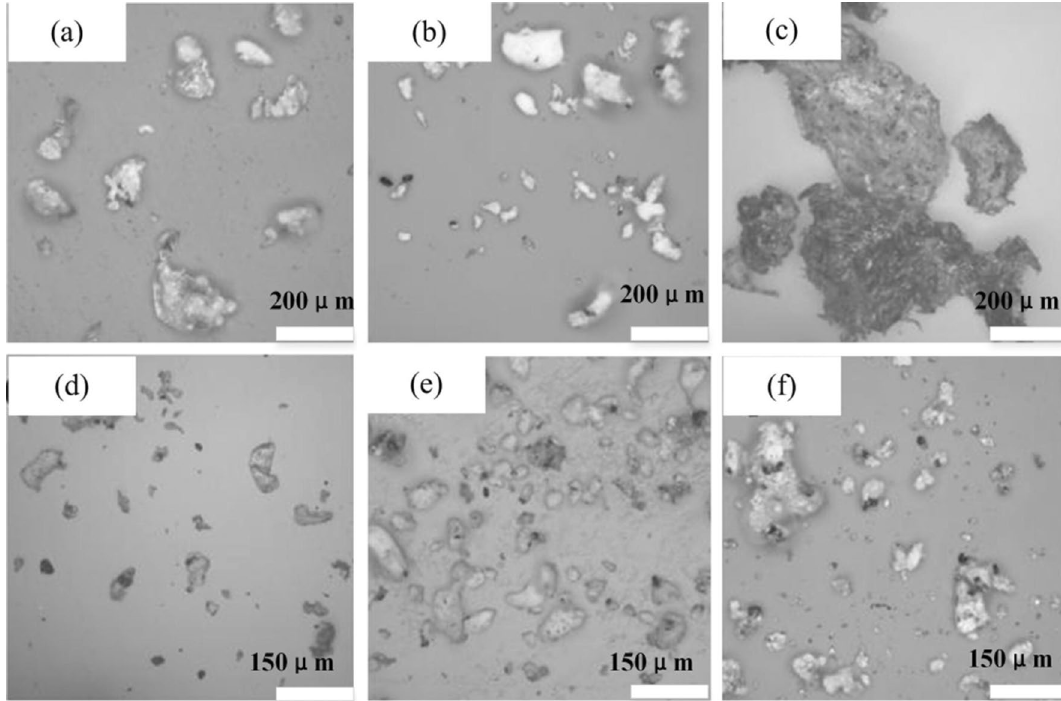
Figure 1. Particle morphology of PEKK and different types of graphene/PEKK composite materials with 1% graphene (200X): ( a ) PEKK; ( b ) GR MG1 /PEKK; ( c ) GR MG2 /PEKK; ( d ) GR MG3 /PEKK ( e ); GR MG4 /PEKK; ( f ) GR XF001W /PEKK (Visio 2021, Prof. WenPing.